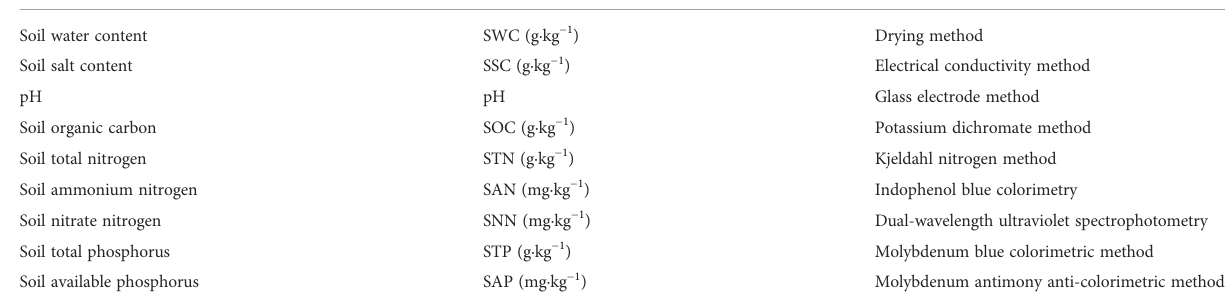
TABLE 1 Measurement methods of soil